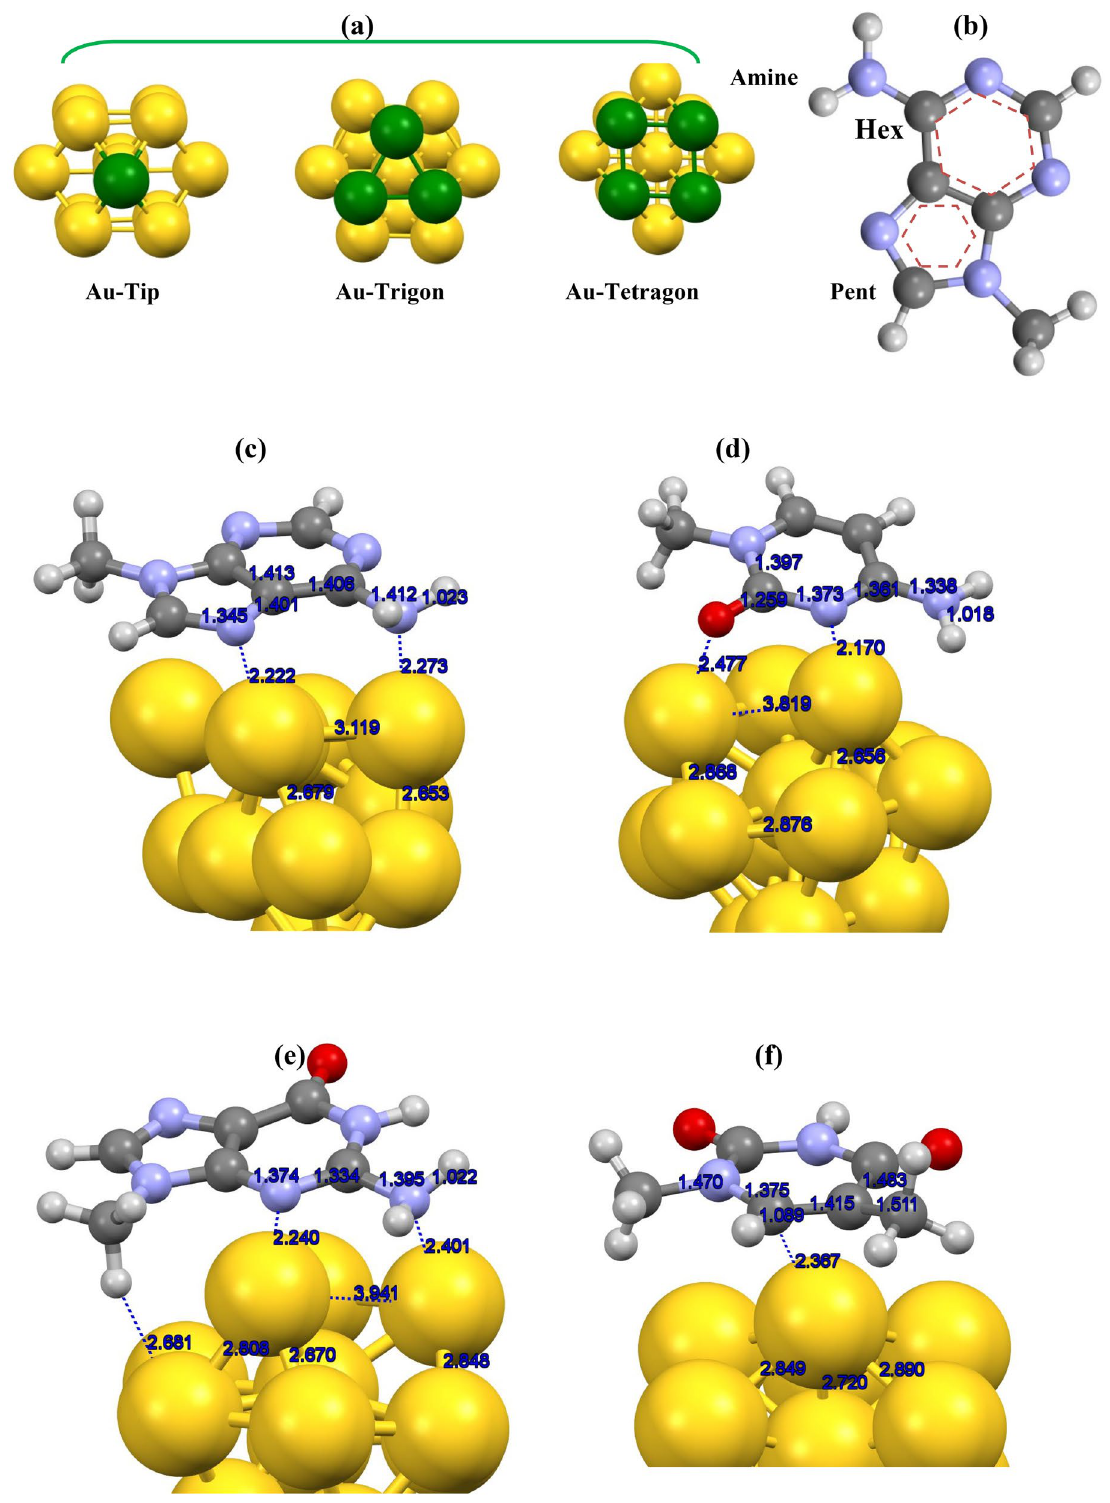
Figure 2. Representation of potential active sites for ( a ) Au13 cluster and ( b ) adenine. Optimized structures of ( c ) adenine/Au13, ( d ) cytosine/Au13, ( e ) guanine/Au13, and ( f ) thymine/Au13 complexes with DFT - D3/TZVP and implicit solvent